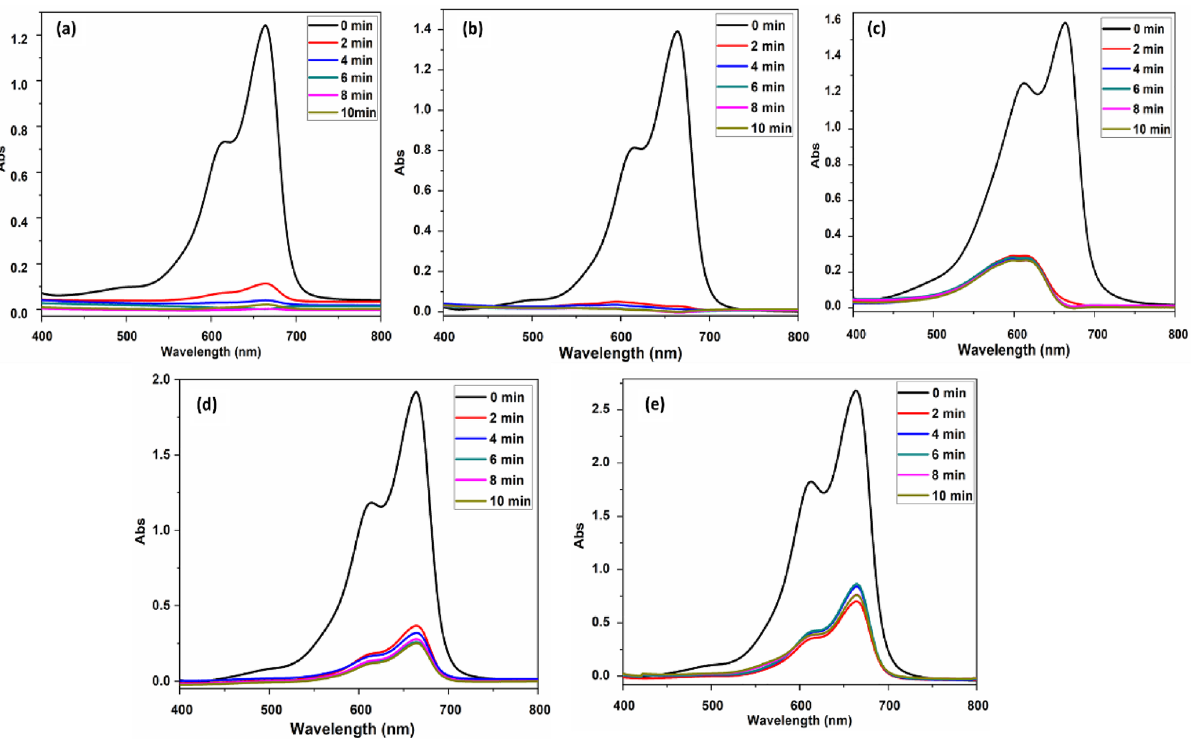
Figure 6. UV–Vis spectra of (MB) solution adsorption at different concentrations ( a , b , c , d , e ) were recorded for (15, 30, 40, 65, 100 ppm) of 40 mg PAK at pH